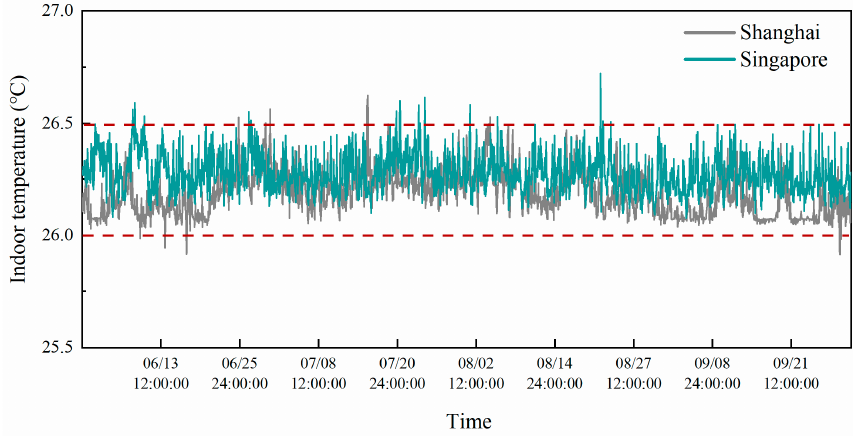
Figure 15. Indoor air temperature when System A operates under different climatic conditions.